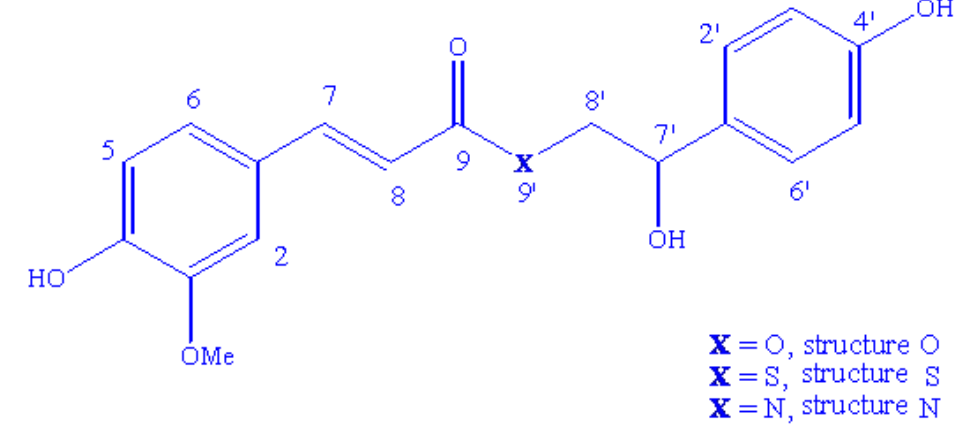
Figure 1. Planar visualization of O , S and N